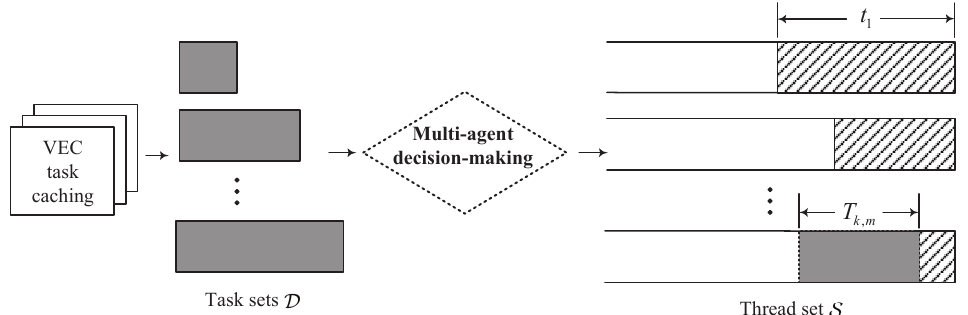
Figure 1. A VEC scenario of vehicular networks.